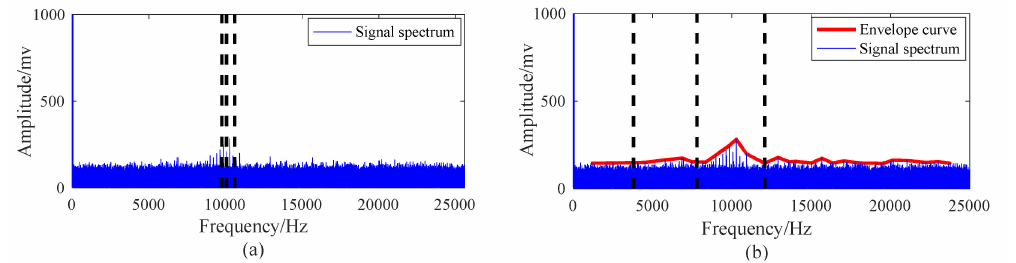
Figure 5. Fourier spectrum segmentation results: ( a ) Fourier spectrum segmentation results of the EWT method; ( b ) Fourier spectrum segmentation results of Improved EWT method.